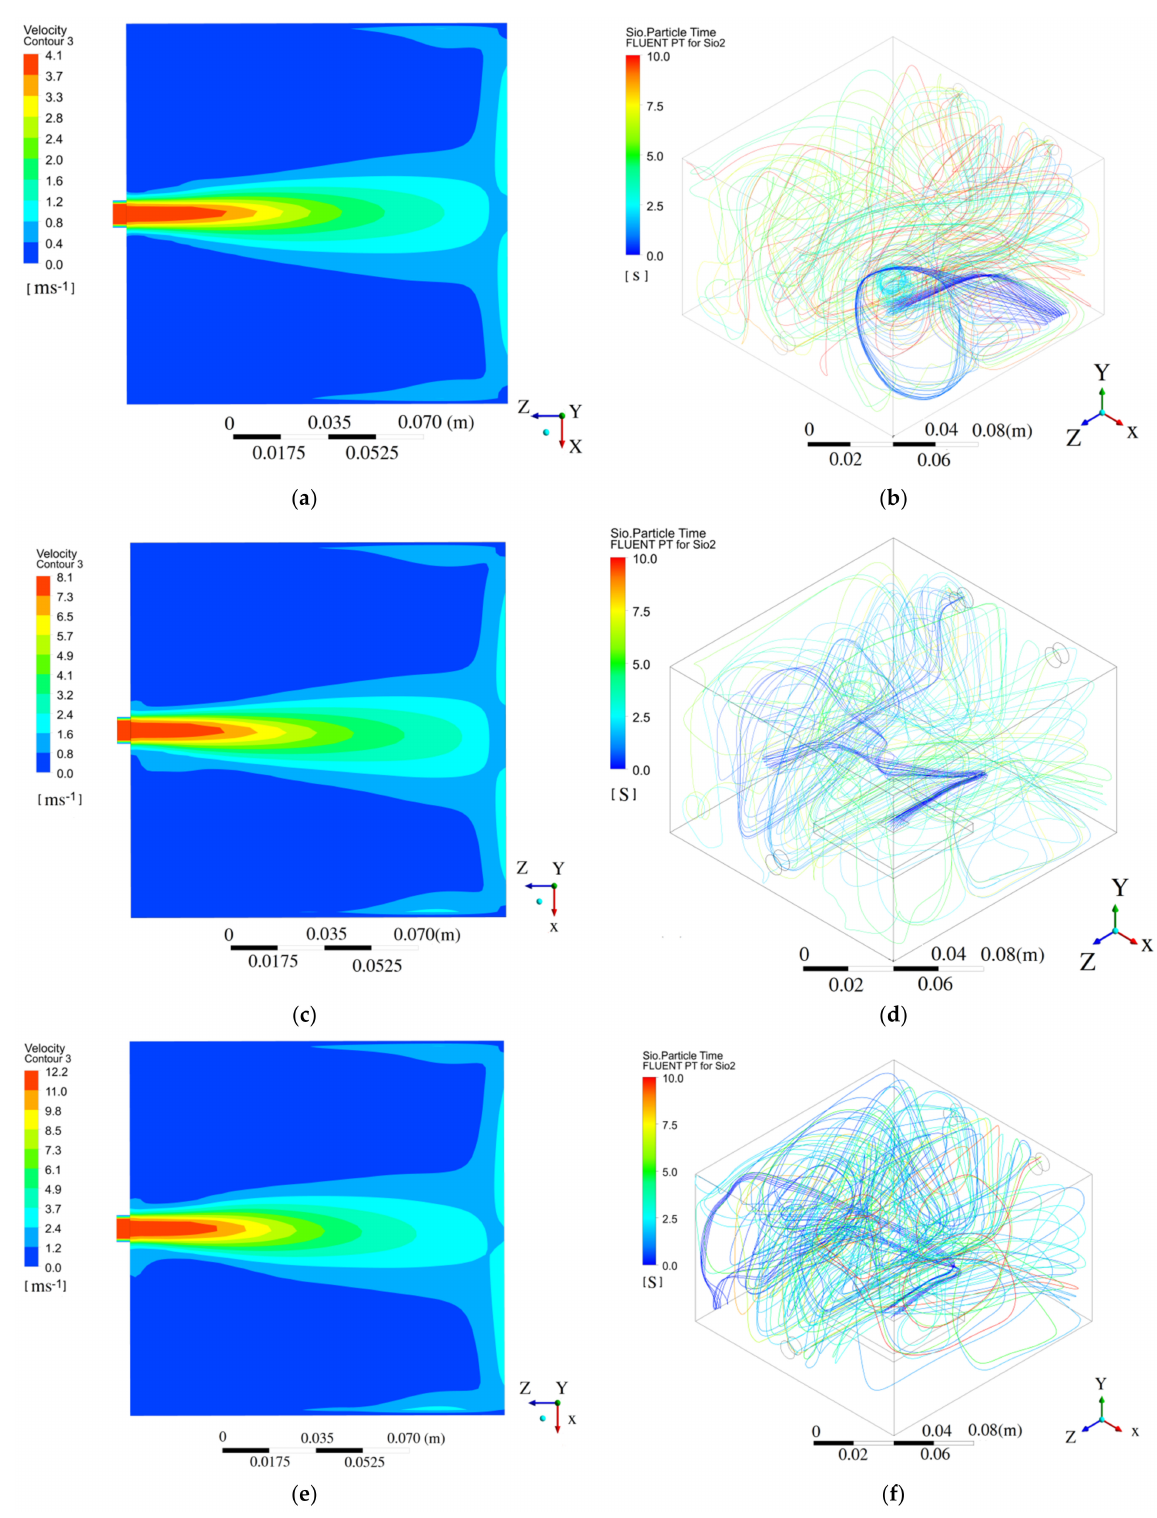
Figure 7. Dust particle simulation under 0.15, 0.2, 0.25 Mpa. ( a ) SiO 2 particle velocity under 0.15 Mpa, ( b ) SiO 2 particle trajectories and distribution under 0.15 Mpa, ( c ) SiO 2 particle velocity under 0.2